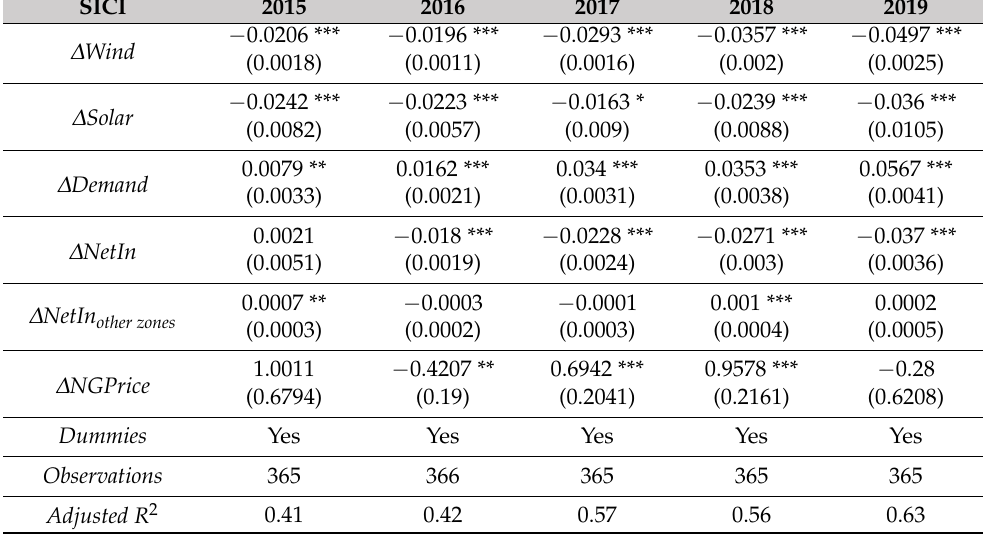
Table A17. OLS estimation of daily changes in electricity prices of SICI; results of Equation